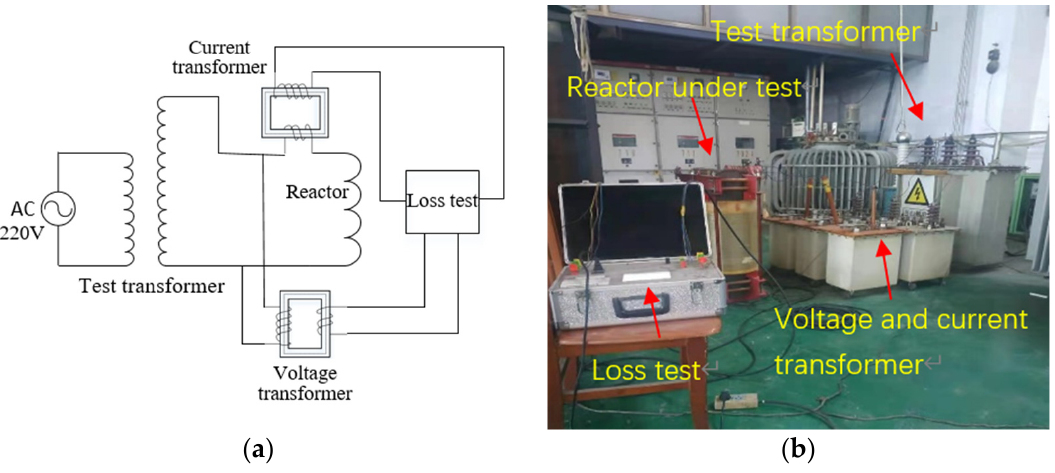
Figure 10. ( a ) The principle of loss test. ( b ) Loss measurement for the trial reactor.